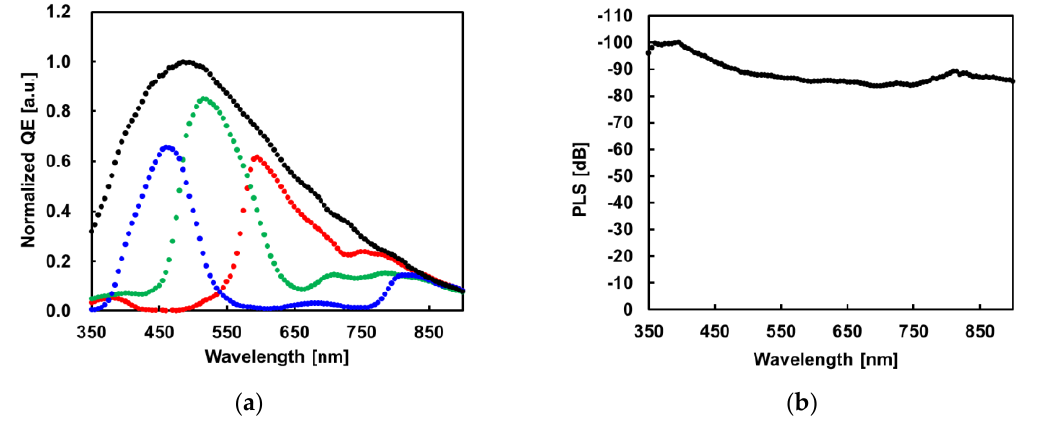
Figure 12. ( a ) Spectral sensitivity and ( b ) Spectral parasitic light sensitivity.